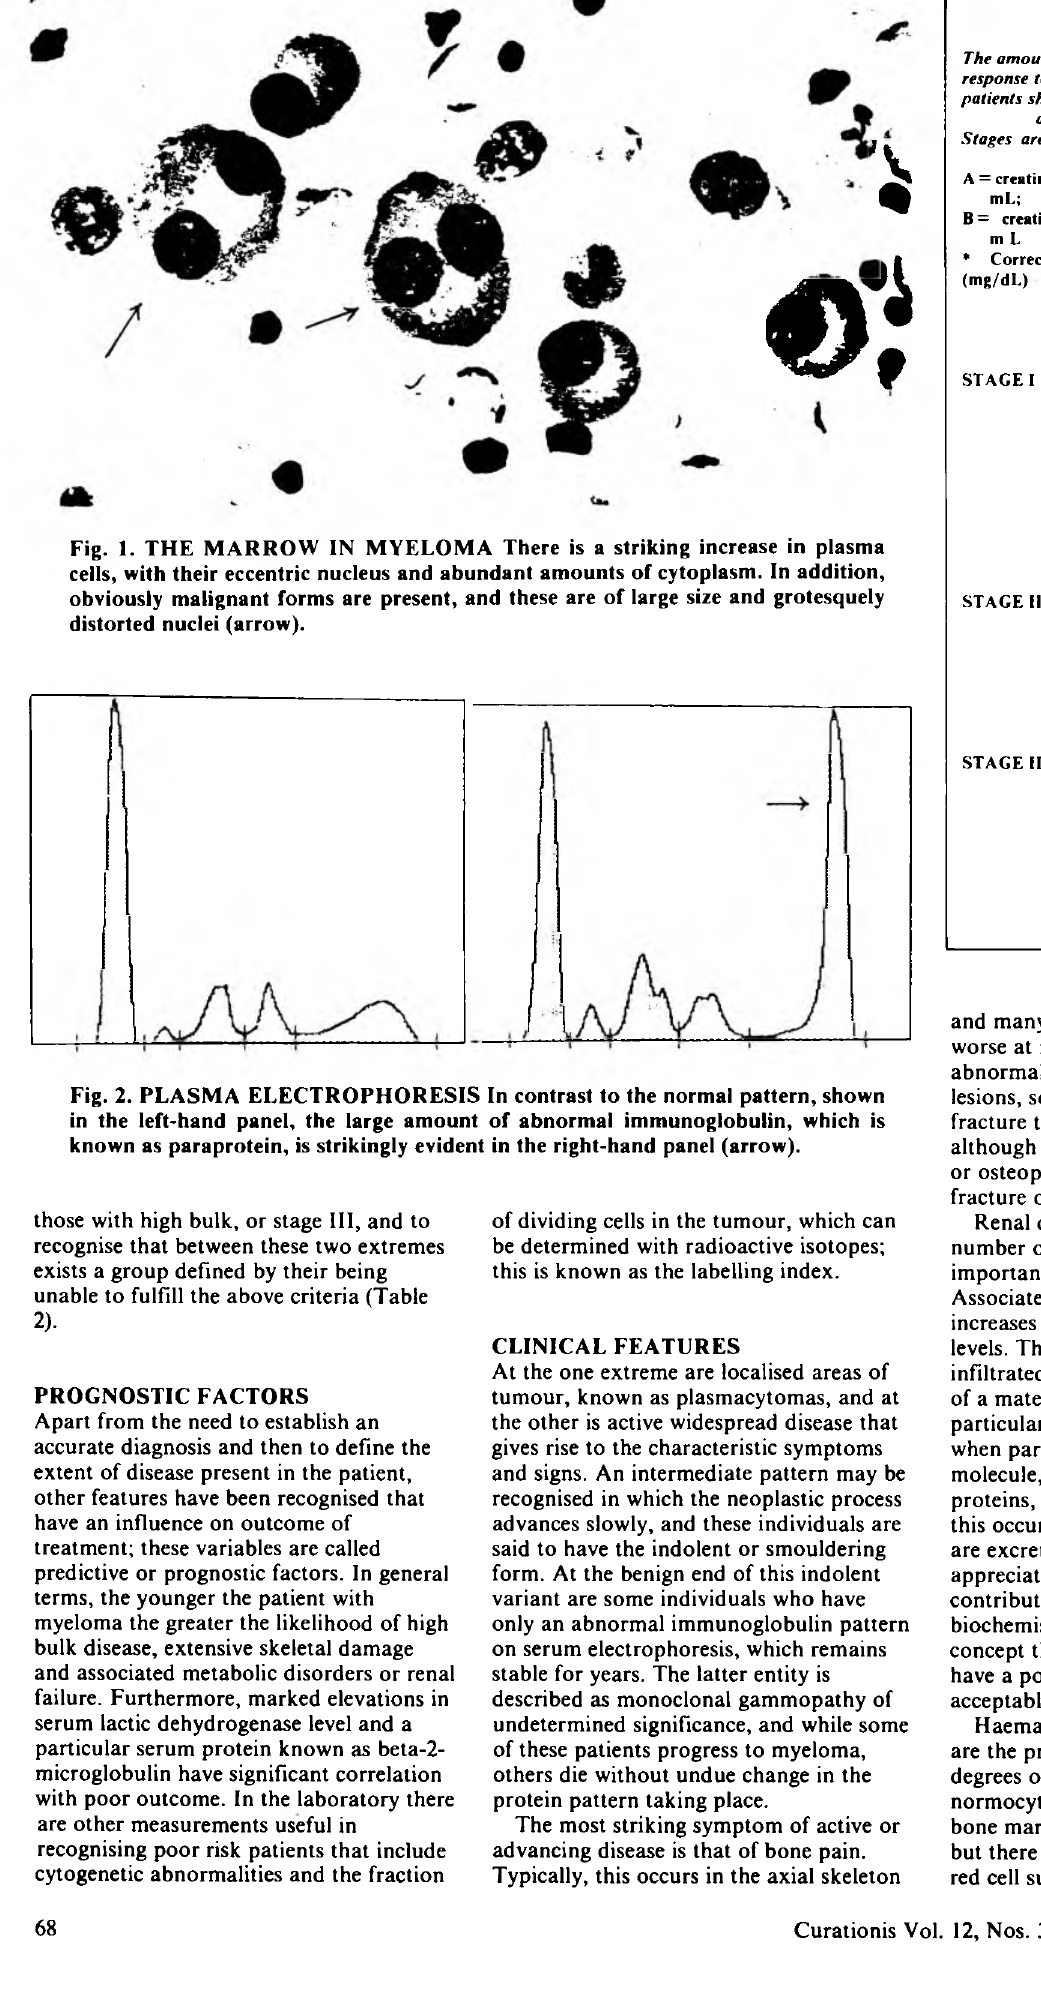
The amount of disease bulk has a direct bearing on response to therapy and survival. It follows that all patients should be classified according to currently acceptable international criteria. Stages are subclassified as A or B according to renal